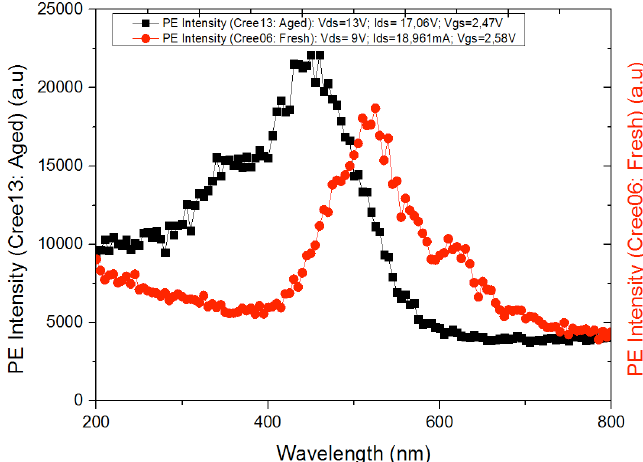
Fig. 10. PE spectrum of the fresh and the HTGB aged